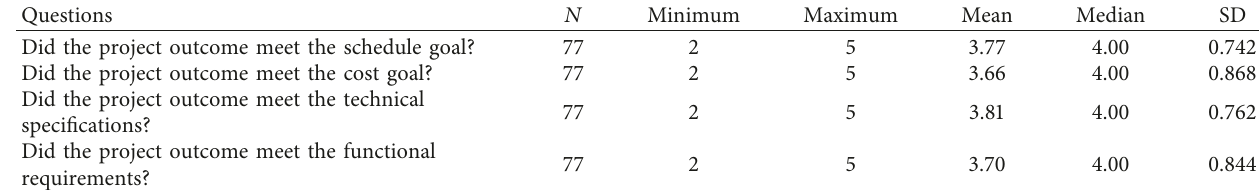
Figure 3: Descriptive data of 12 types of private partner respondents. Table 3: Descriptive data of the project success dimension “meeting design goals.”